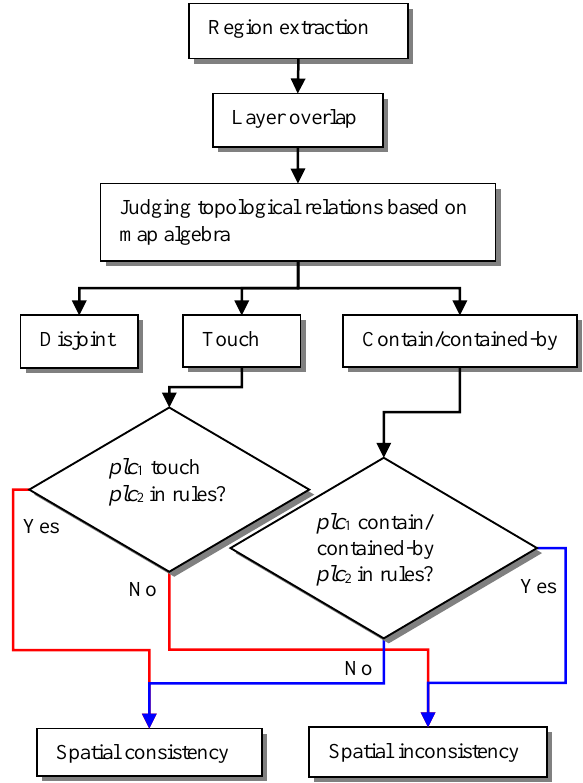
Figure 5. The underpinning for algorithm of region overlap